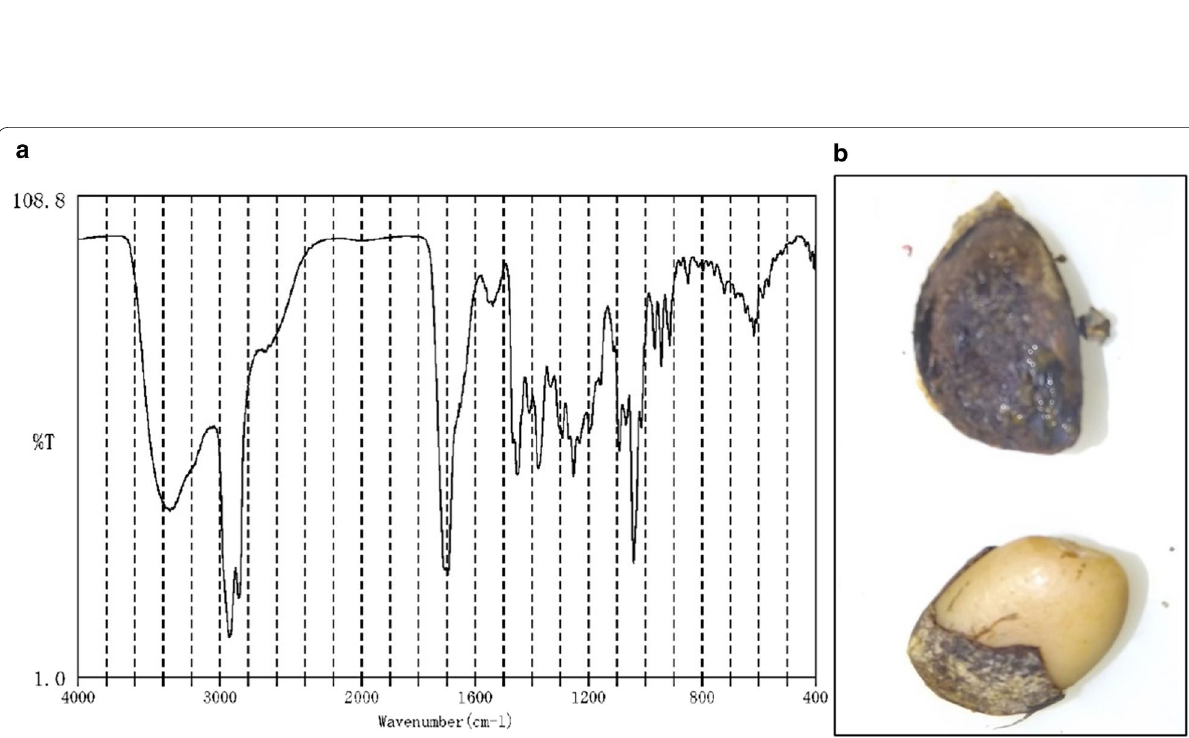
Fig. 5 Spectrophotometric analysis and contents of the stones. a The absorbance pattern of deoxycholic acid (DCA) is noted; b some stones contain a persimmon seed-like component in their